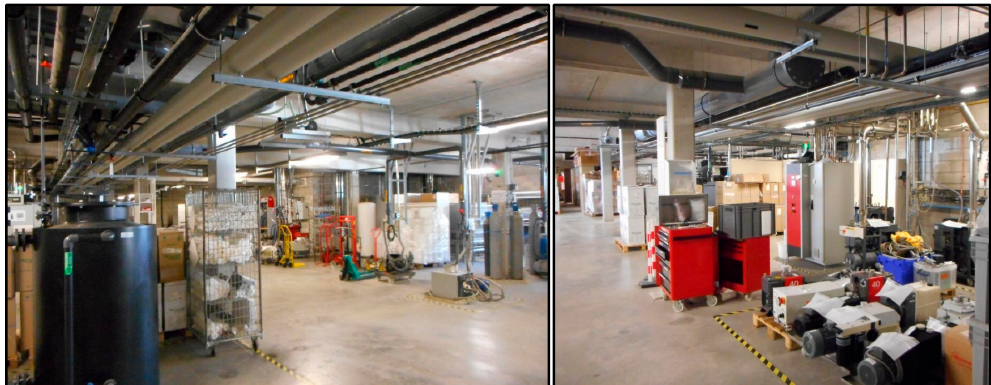
Figure 1. Industrial environments considered in this paper. The walls, metallic pipes and machines generate undesirable clutter that challenge the long-range detection and wireless reading of zero-power sensors for the monitoring of pressure.